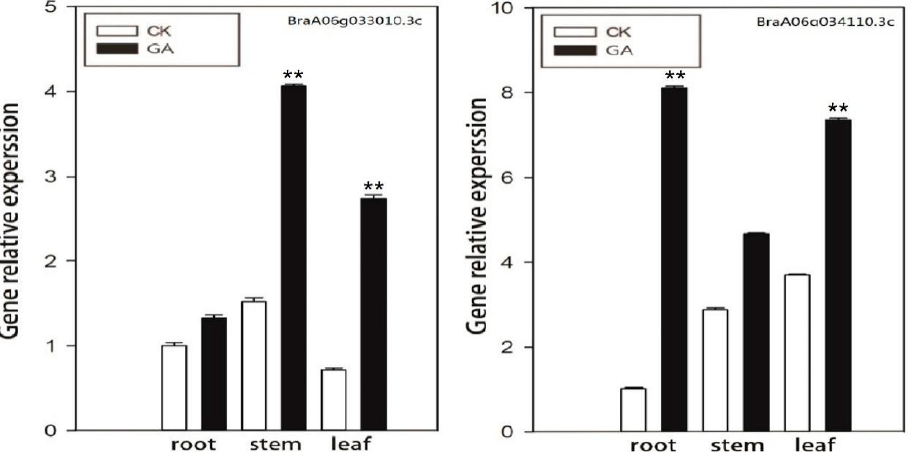
Figure 7. Expression patterns of gibberellin (GA)-related genes in plant tissue. Expression levels of BraA06g033010.3C and BraA06g034110.3C in the leaf, stem and root according to quantitative real-time reverse transcription PCR (qRT-PCR) analysis. Error bars indicate the standard errors ( n = 3); white is mutant Brcd1 YS is shown in white and GA treatment is shown in black, ** p < 0.01.